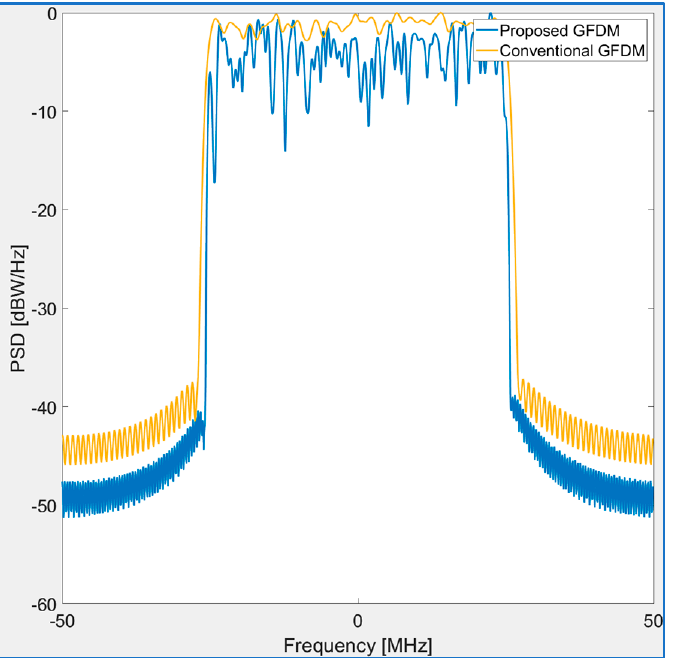
Figure 5 . Power spectral density of the proposed system compared with that of the conventional system .